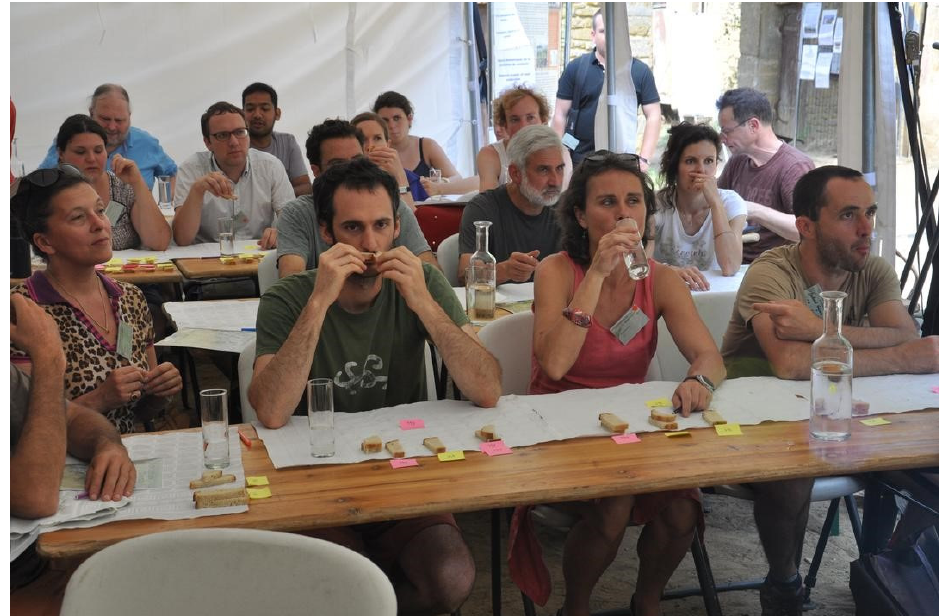
Figure 2. Napping test on 11 bread wheats at the ‘Let’s Liberate Diversity’ at Meix devant Virton, Belgium, June 2017.